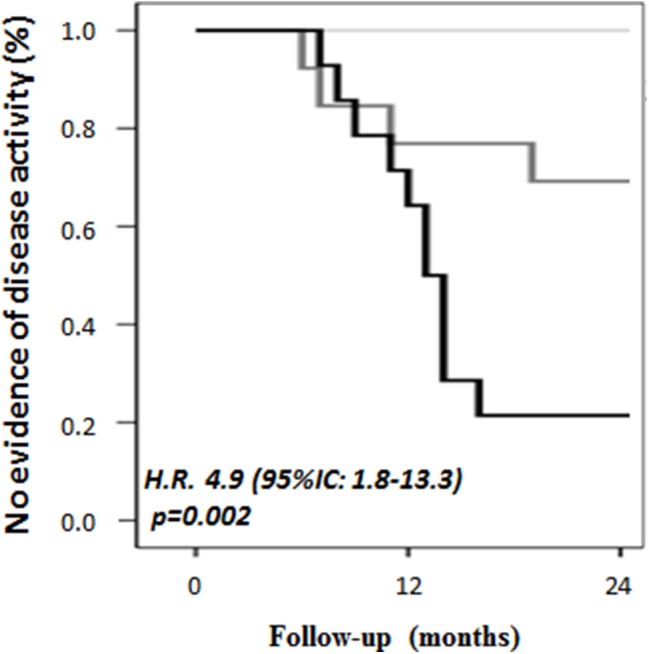
CSF CCL-3 associates with a higher probability of disease activity during follow-up. RRMS patients were divided into three groups based on ROC cut-off and on the cut-off determined by the 95%CI upper limit calculated on ONIND (i.e., μ ± 1.96*σ, i.e., 0.798 pg/ml). RRMSCCL−3low (<0.495 pg/ml) did not present any relapse in the following 24 months, while RRMSCCL−3medium (0.495–0.798 pg/ml) and RRMSCCL−3high (>0.798 pg/ml) had a significantly higher rate of disease activity (p = 0.002).